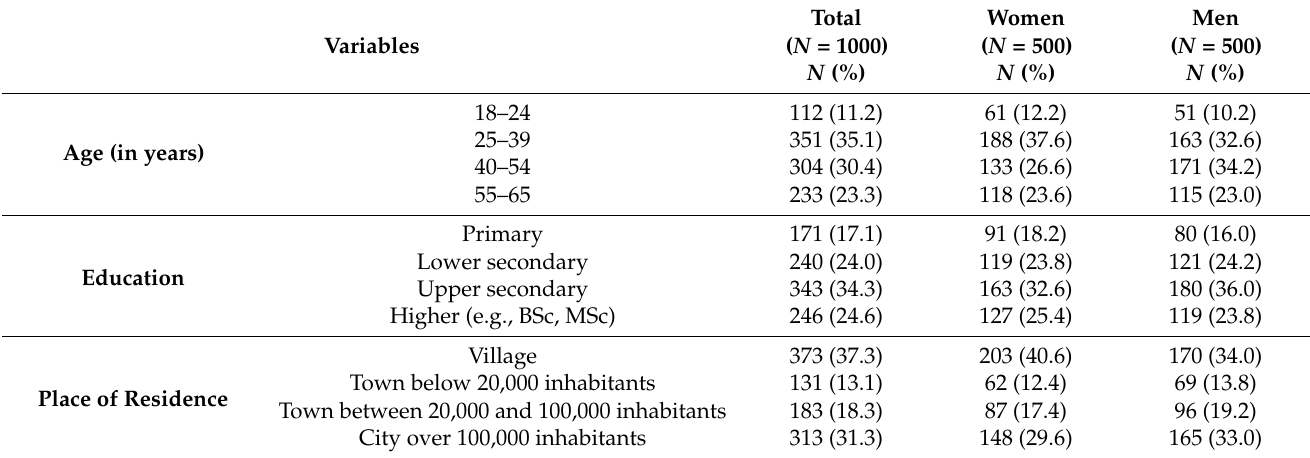
Table 1. Socio-demographic characteristics of the study sample.